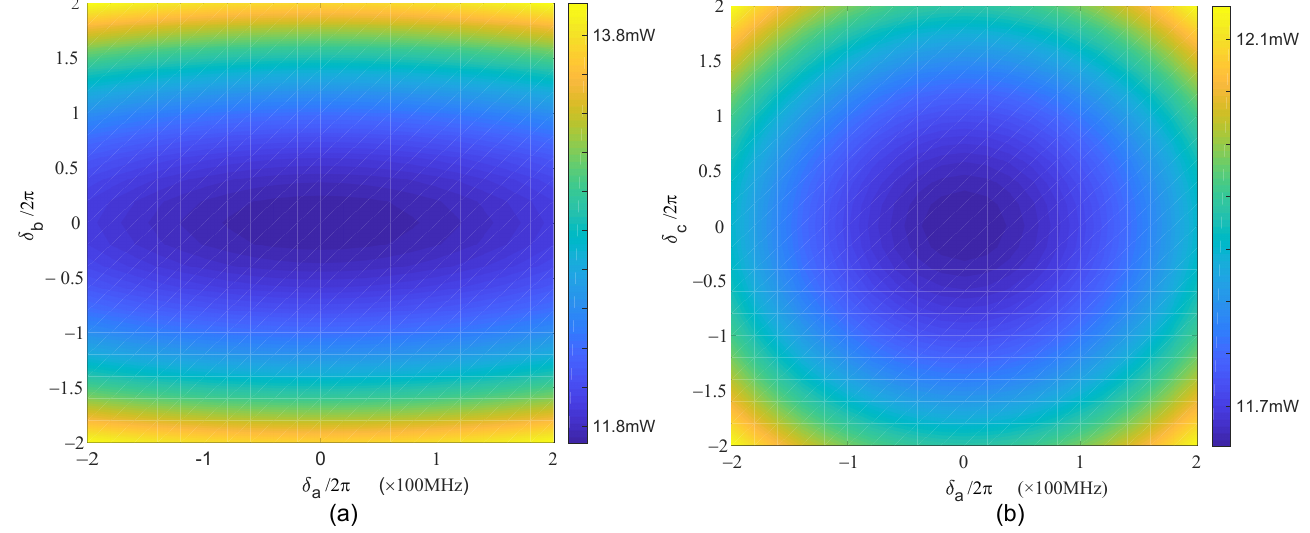
Figure 4. ( a ) Contour plot of power threshold as a function of the detuning δ a between the input mode a and pump field, as well as the detuning δ b between the signal mode b and the pump field, δ a = ω a − ω p , δ b = ω b − 2 ω p , and δ c = 0. ( b ) Contour plot of power threshold as a function of the detuning δ c between the gain mode c and the pump field as well as the detuning δ a , δ c = ω c − ω p , and δ b = 0. Other parameters are κ a = 1.92 GHz, κ b = 480 MHz, κ c = − 1 GHz, κ a ,1 = 960 MHz, and g = 80